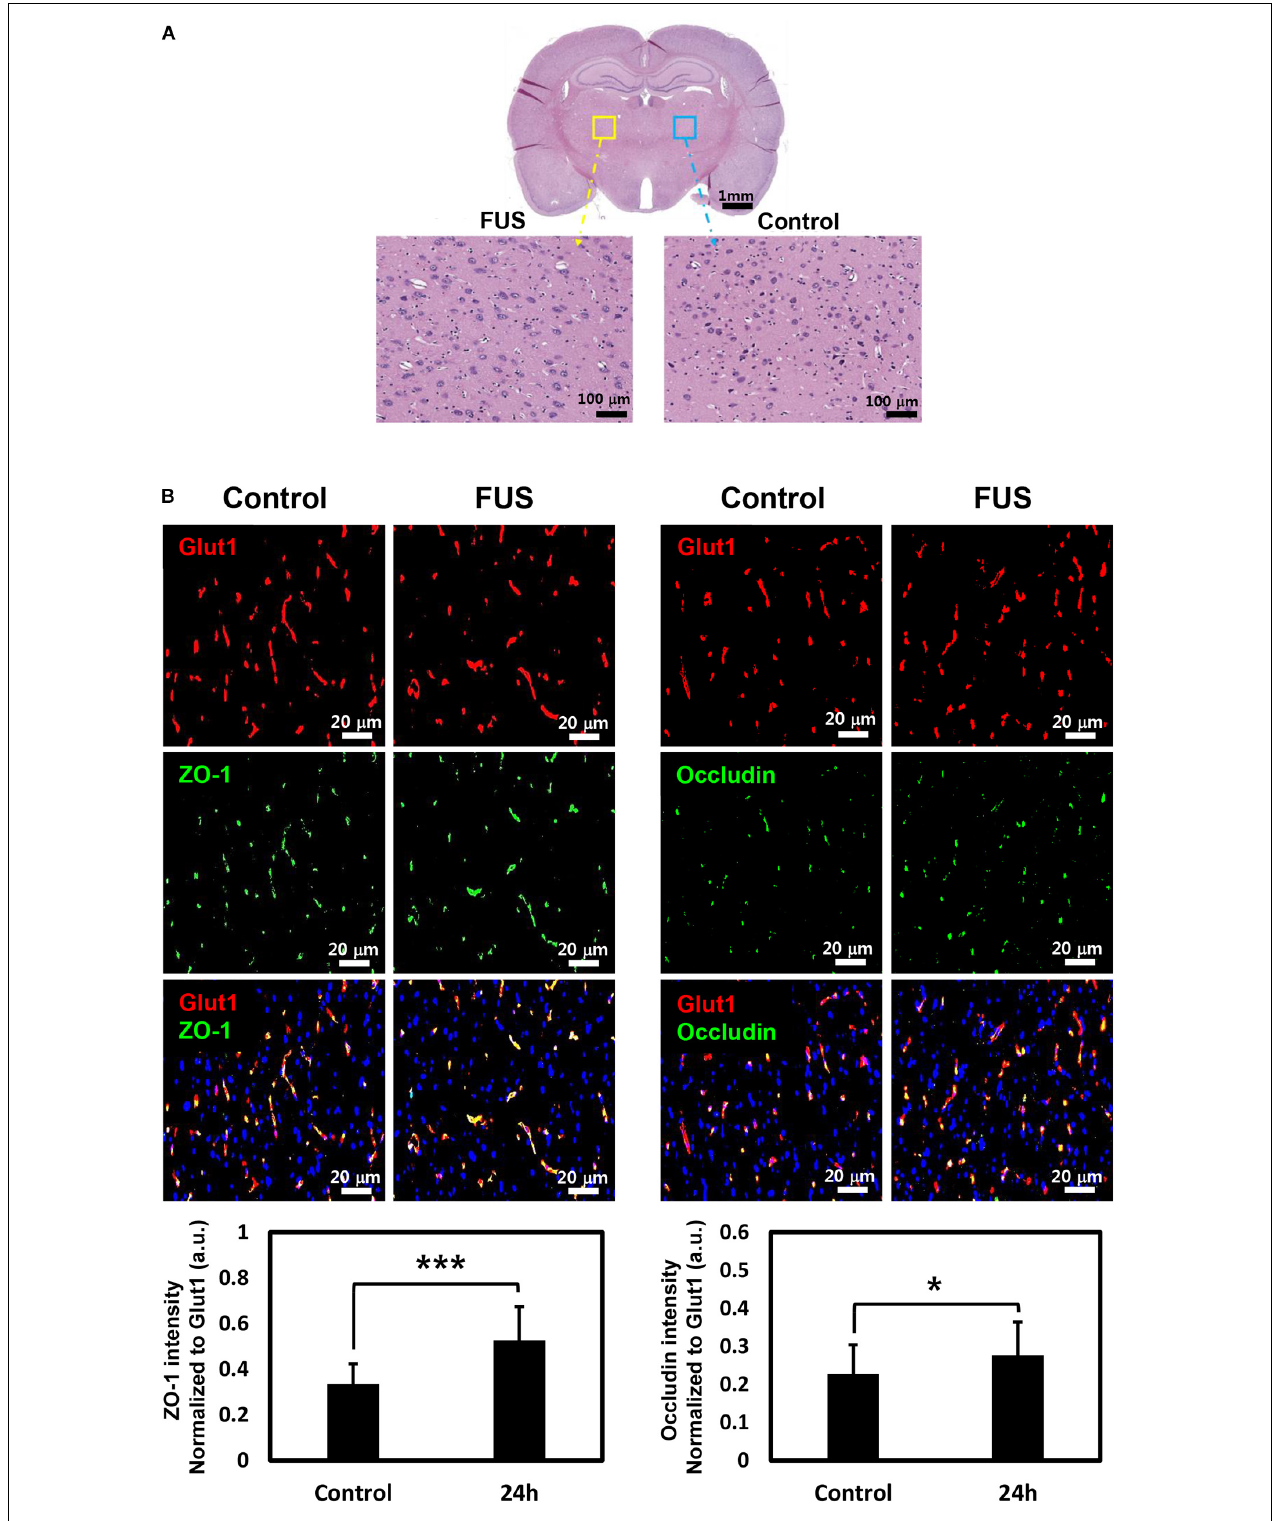
FIGURE 6 | Histology and immunostaining of tight junction (TJ) proteins. (A) Whole brain section was stained with H&E at 4 h post-BBBD (top). Left enlarged image showed BBBD region (yellow square box) and right enlarged image showed control region (blue square box) (B) TJ protein, ZO-1 (green, left panel), and occludin (green, right panel) was double-stained with vascular endothelial cell marker, Glut1 (red) at 24 h post-BBBD. The fluorescence intensities of ZO-1 (bottom, left) and occludin (bottom, right) were normalized to Glut1 fluorescent. It was presented as the mean ± SD (multiple ROIs ( n = 30) per hemisphere, ∗ P < 0.05, ∗∗∗ P < 0.001).